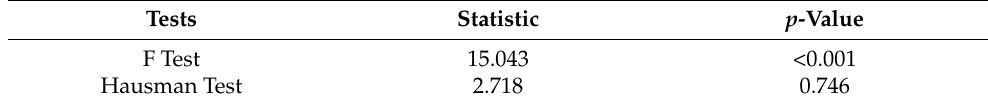
Table 7. Statistic test results of